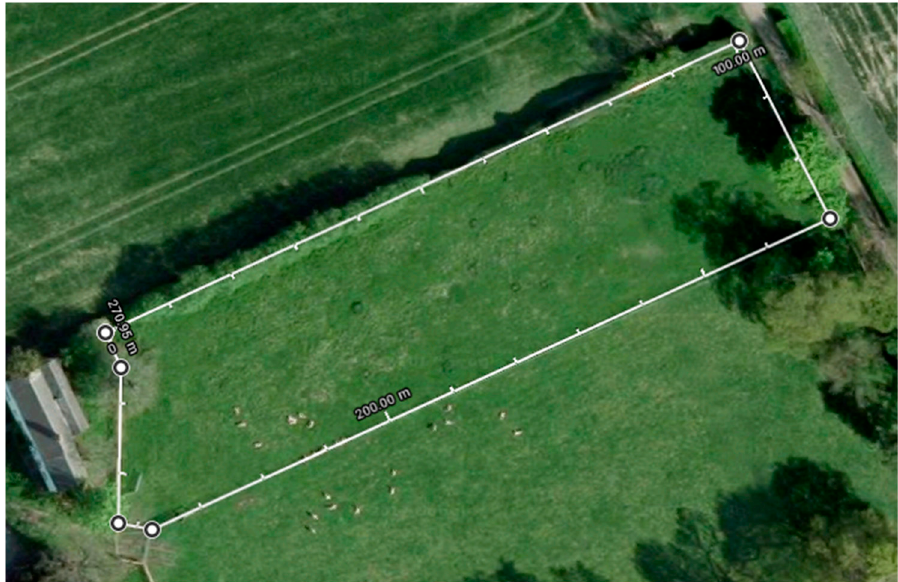
Figure 6. Satellite view of field with drawn and labelled perimeter.